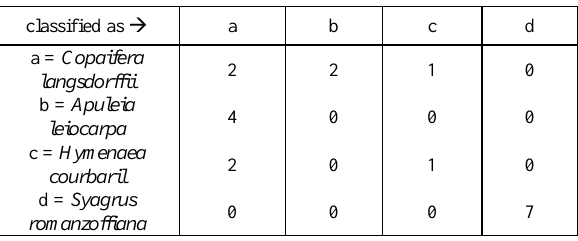
Table 8. Confusion matrix of the validation set when RF model is applied in the region-based approach